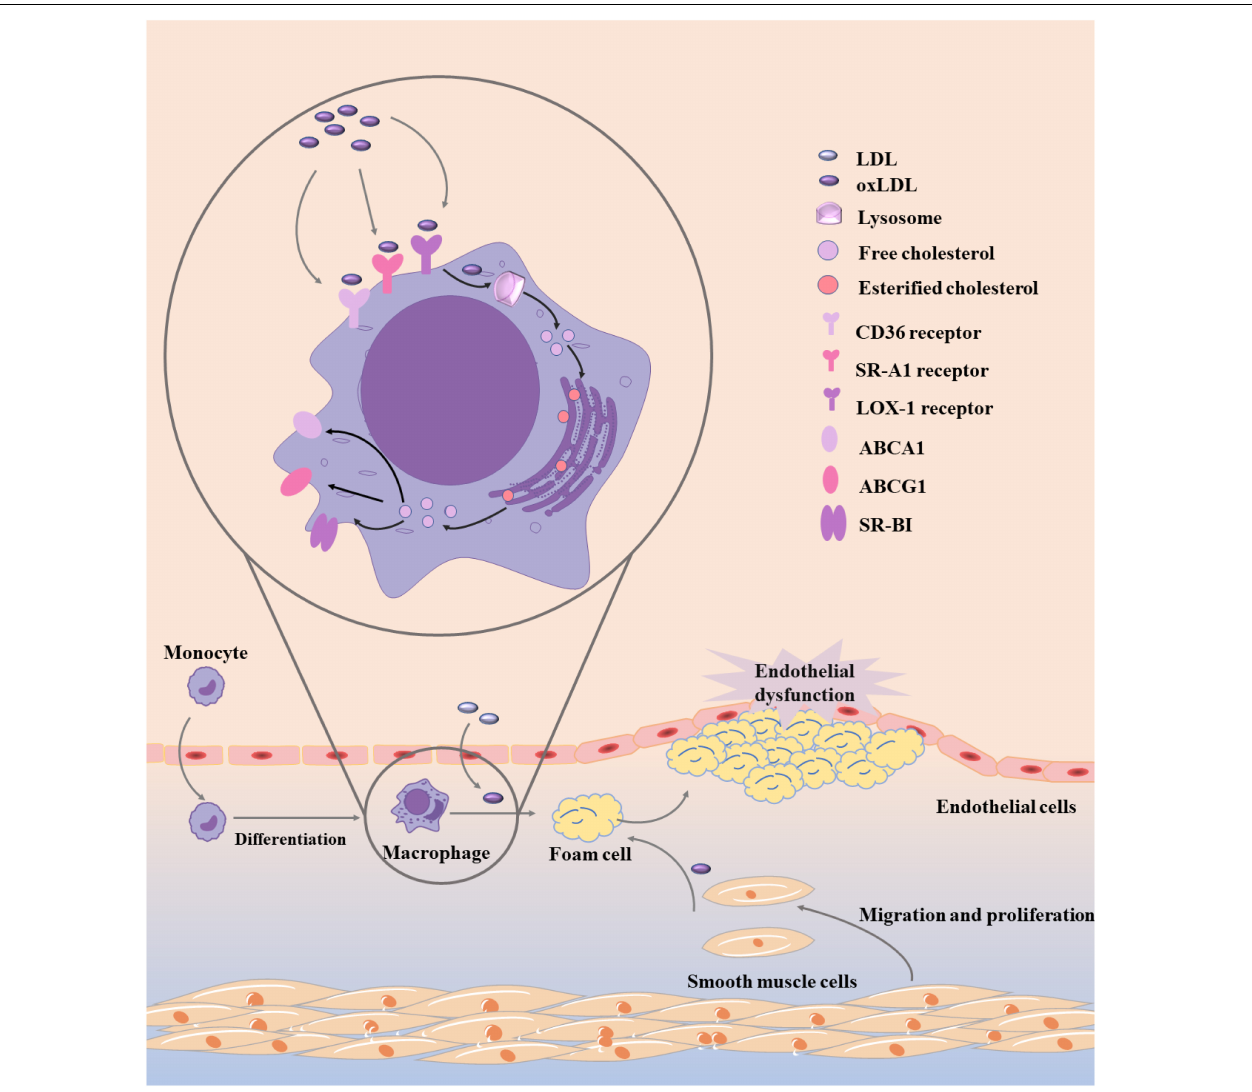
FIGURE 2 | Development of foam cells in atherosclerosis. Monocytes recruit to the area of LDL modification and differentiate into macrophages, which can quickly recognize and absorb modified LDL into foam cells. Besides the modified LDL, the disorder of lipid metabolism in macrophages is another important factor of foam cell production, and the homeostasis of lipid metabolism in macrophages is mainly coordinated by three main processes, including cholesterol uptake, cholesterol esterification, and cholesterol